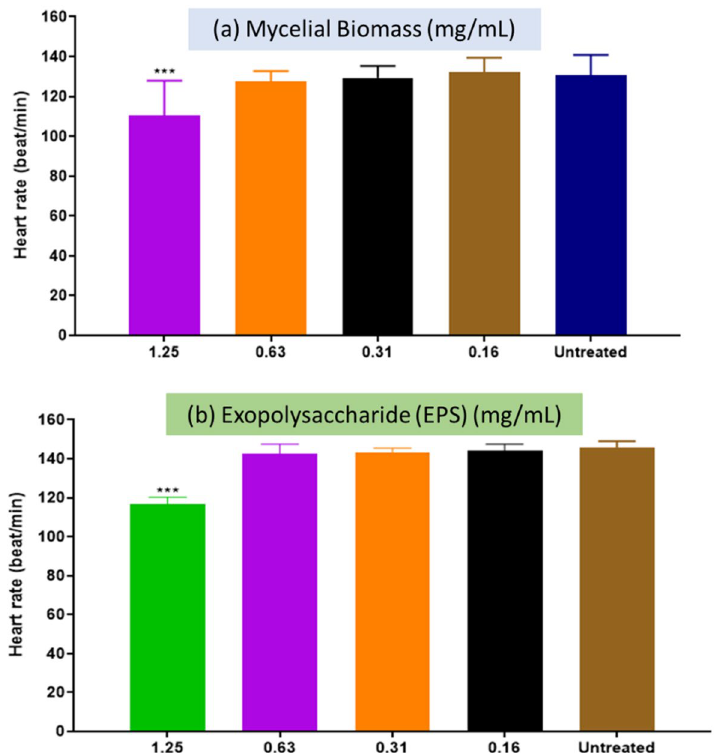
Figure 4. Effect of Tiger milk mushroom Lignosus rhinocerus strain ABI, with MB and EPS extract at concentrations of 0.16–10 mg/mL on the heart rate of zebrafish embryos at 96 HPF. *** p < 0.05 significantly different from the untreated group (zebrafish embryos in medium only). *P < 0.05 significantly different from the untreated group (zebrafish embryos in medium only). For ( a ) MB, no data at concentrations > 2.5